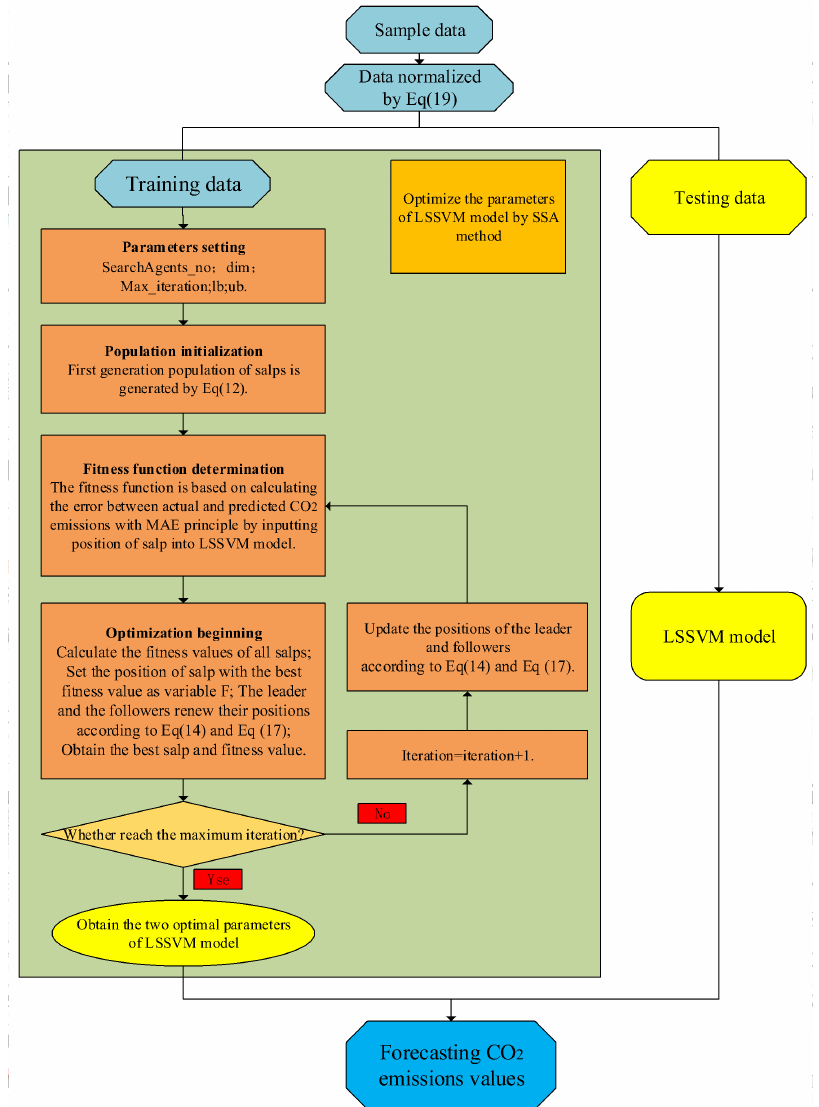
Figure 2. The procedure of the SSA-LSSVM model for CO 2 emissions